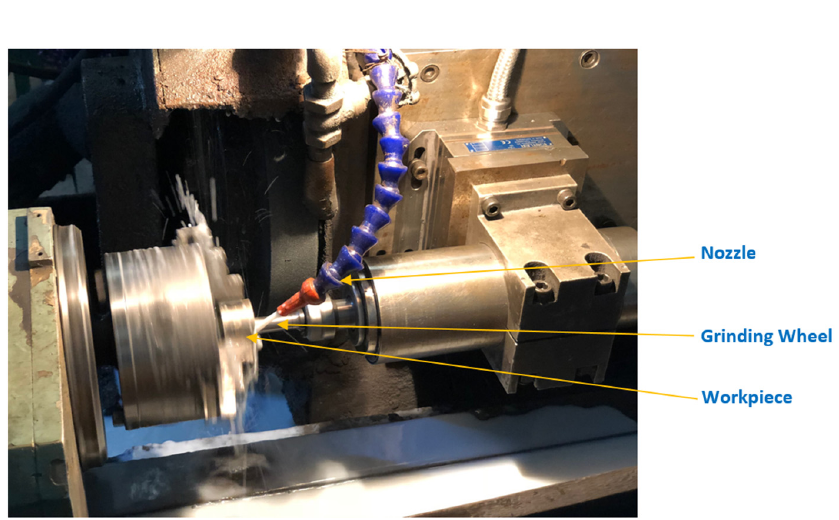
Figure 1. Experimental setup. Table 4. Experimental plan and output results.